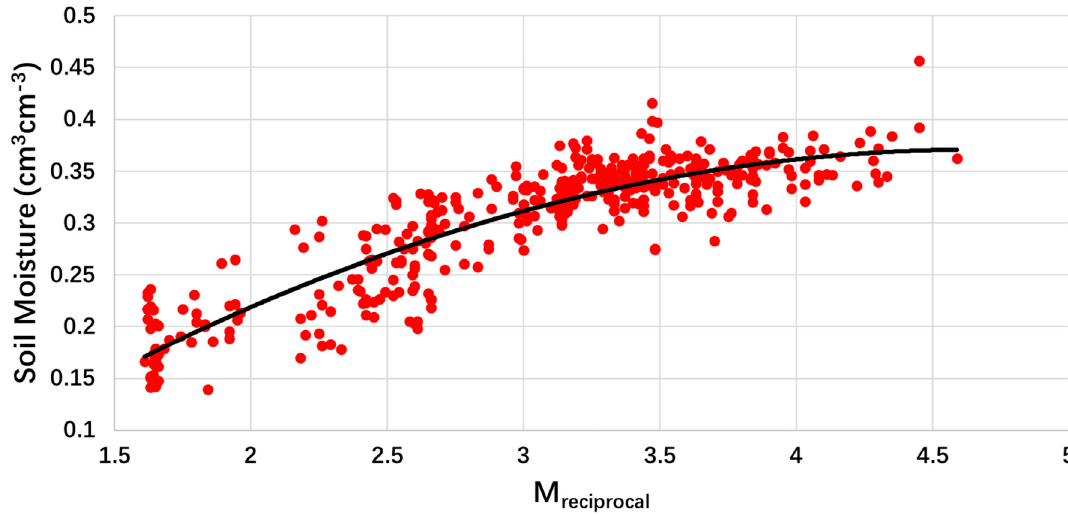
Figure 11. Parabolic modeling based on regression analysis of Wuhan experiment.